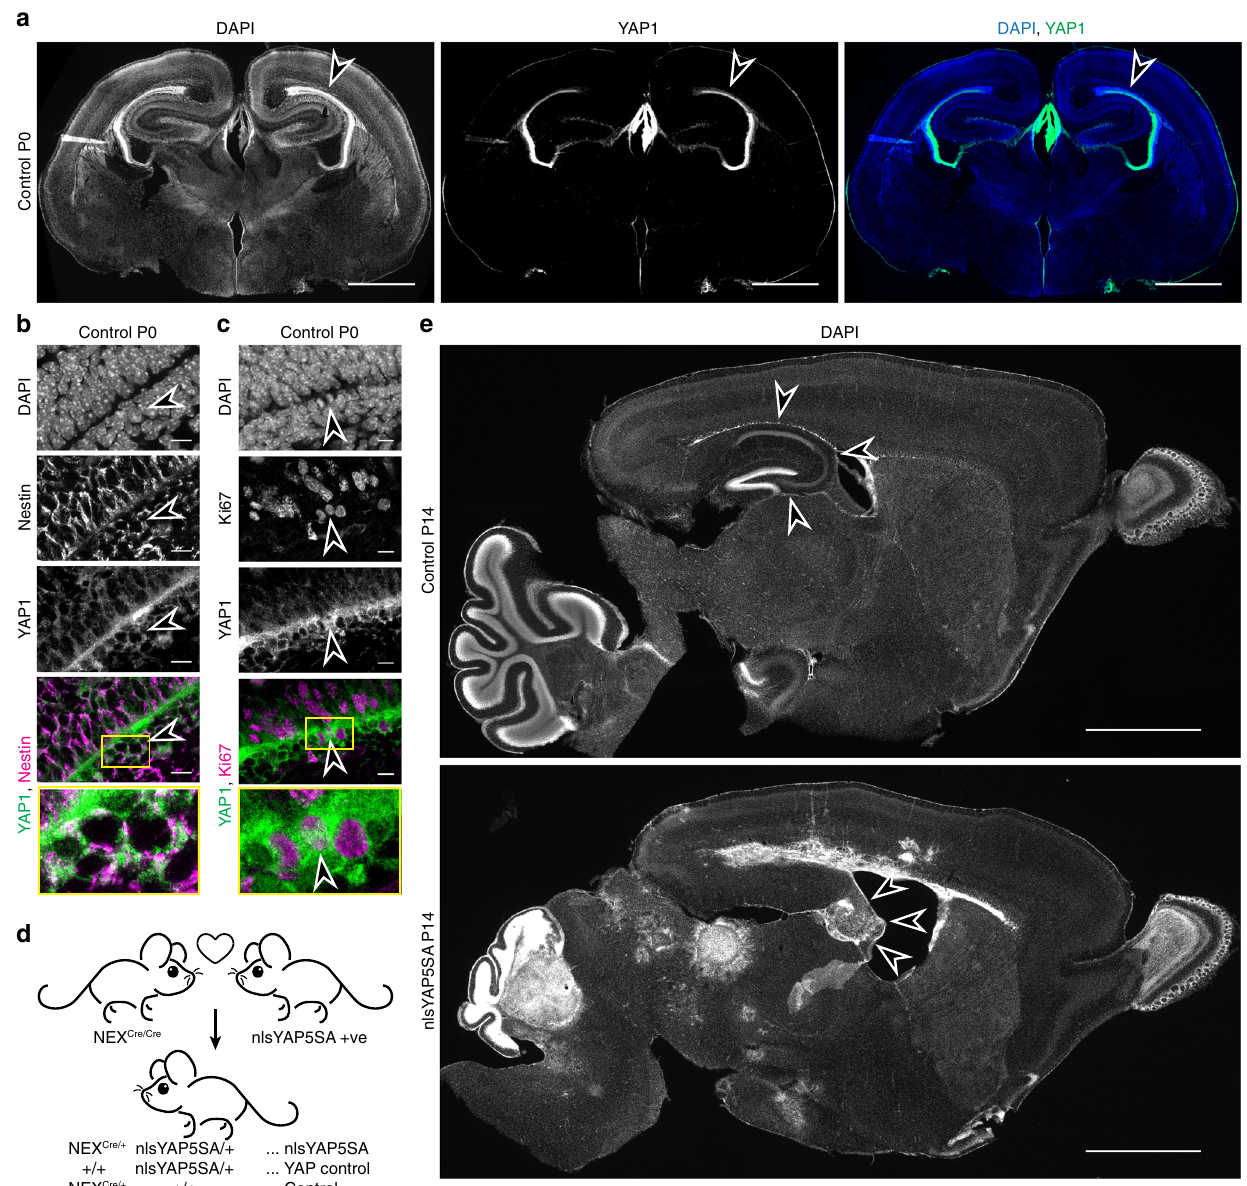
Fig. 1 YAP1 is present in ependymal layer and its regulation is critical for brain development. a Coronal view of control P0 mouse brain sections immuno fl uorescence stained for YAP1. Arrowhead pointing at strong positive staining in the ependymal layer, scale bars = 1 mm. b – c Higher magni fi cations of ependymal layer/ventricular zone in control mice at P0. b Immunostainings with YAP1 and Nestin and c . Immunostainings with YAP1 and Ki67 show colocalization (arrows point to cells with colocalizations, overlap shown in white colour). Scale bars = 10 µ m. d Breeding scheme to generate mice expressing nlsYAP5SA under the control of NEX-Cre (referred to as nlsYAP5SA). Mice with only one allele of NEX-Cre without the YAP1 transgene were used as controls. e Sagittal vibratome sections of the whole brain of Control and nlsYAP5SA mice are shown at P14. In nlsYAP5SA mice, ependymal layer is destructed, multiple tumours are formed across the brain as shown by DAPI stained nuclei and hippocampus is not developed. Arrowheads point at hippocampus. Scale bar = 1 P15 (Supplementary Fig. 3a, b). Upon inspection of LATS1/2 cKO mice at P0 – P21 age groups, we found that 67% at P5 – P7 and represses the maturation of hepatocytes thereby causing pre-natal 100% at P8 – P21 developed tumours whereas no tumours were lethality 17 . Whether or not LATS1/2 has a role in neuronal dif- ferentiation in mammals is not known. We tested if de fi ciency in found before P5 (Supplementary Fig. 3c). Multiple clonal fore- YAP1 phosphoregulation by LATS1/2 is suf fi cient to cause brain tumours, originating invariably at the ependymal layer were tumour formation by conditionally knocking out Lats1 and Lats2, found in all LATS1/2 cKOs, but not in controls or individual in NEX-Cre lineage (Fig. 3a). We found that dual LATS1/2 con- LATS1 cKOs or LATS2 cKO at P20 (18/18 dual knockout, 0/3 ditional knockouts (cKOs), but not individual LATS1 cKOs or LATS1 cKO, 0/3 LATS2 cKO, 0/6 controls), indicating redun- LATS2 cKOs, have signi fi cantly reduced body weight by P19-P21 dancy between LATS1 and LATS2. Animals showed multifocal, compared with control littermates, with an onset of difference at discrete tumours indicating their synchronous origin (Fig. 3b).